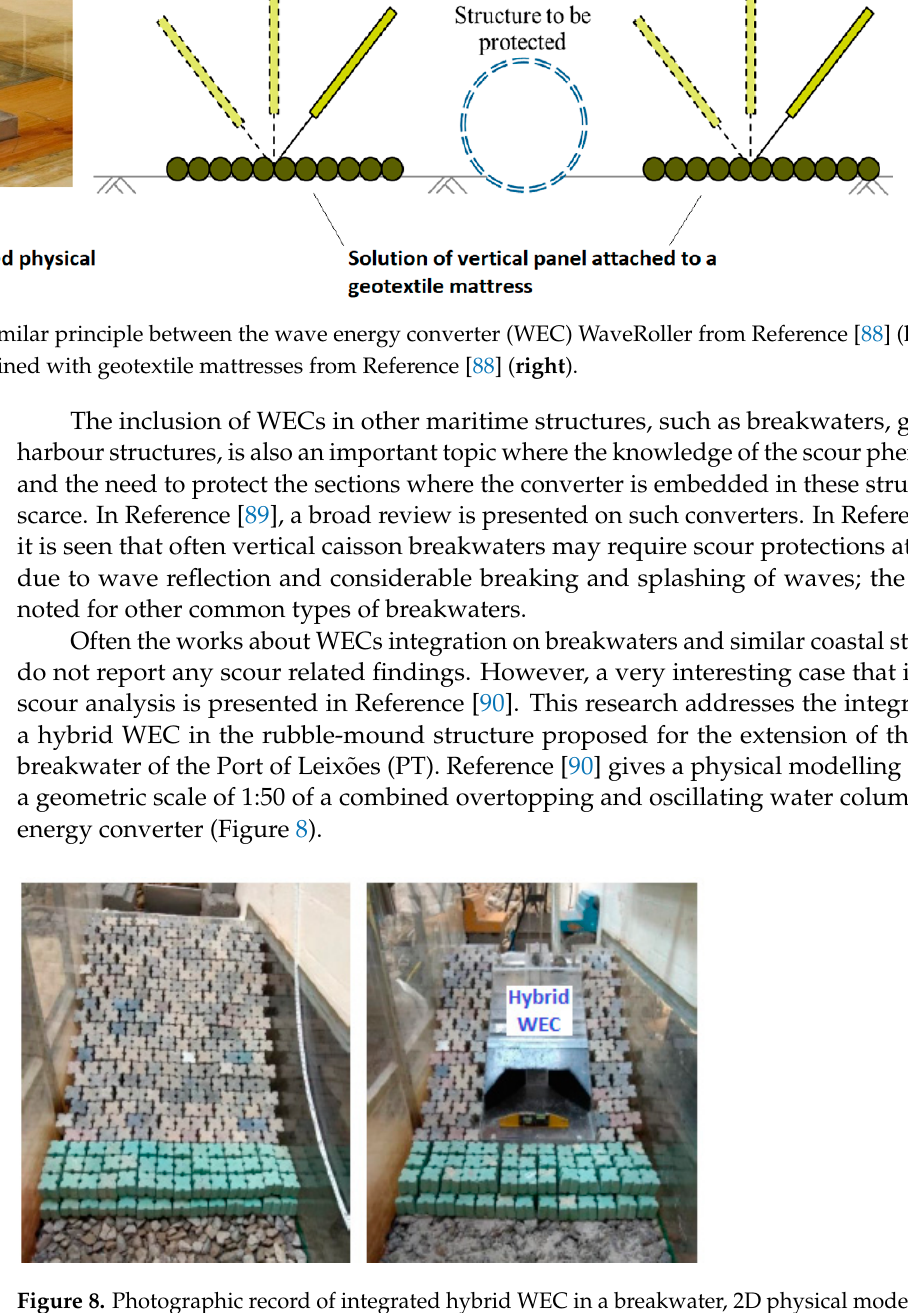
Figure 9. Sideview of the integrated WEC into the breakwater and central cross-section profiles.